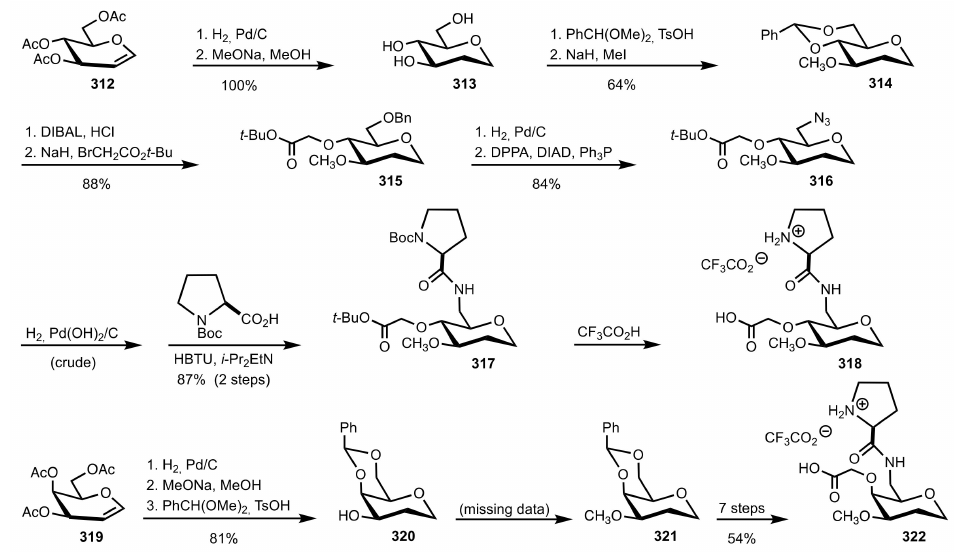
Scheme 87. The synthesis of the sugar prolinamide organocatalysts 318 and 322 .